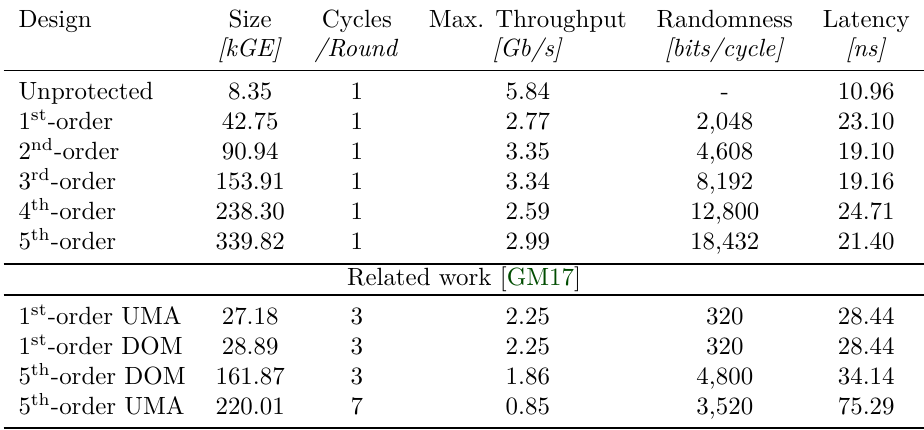
Table 1: Results for Ascon -128 with one cycle per round (64